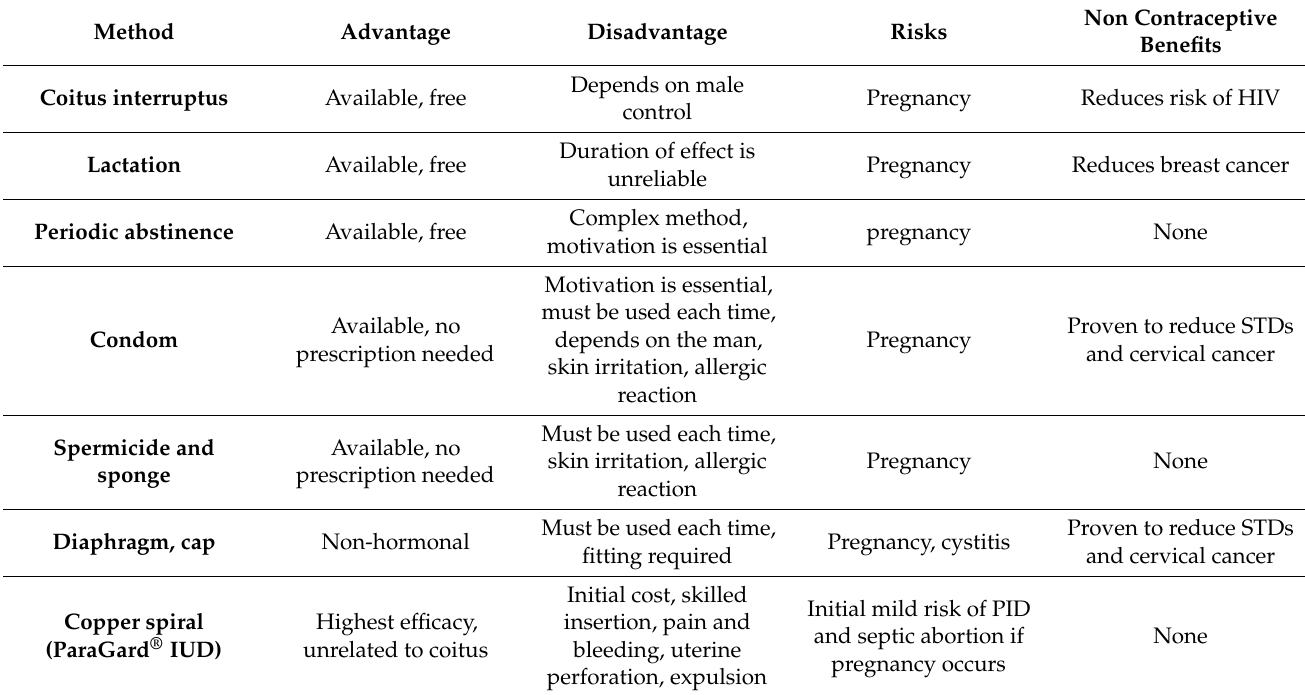
Table 1. Overview of contraceptive